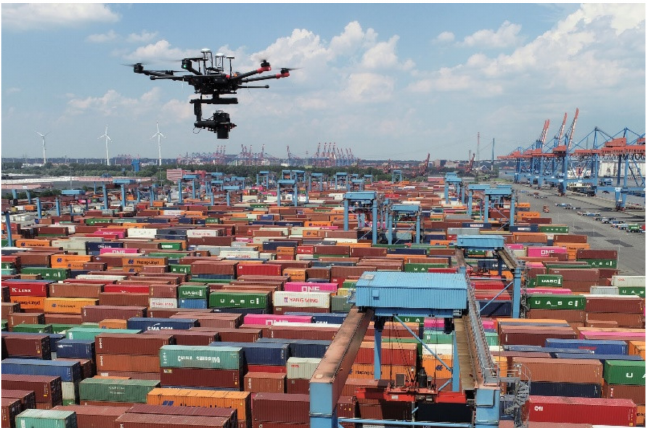
Figure 5. The UAV in flight with the camera.